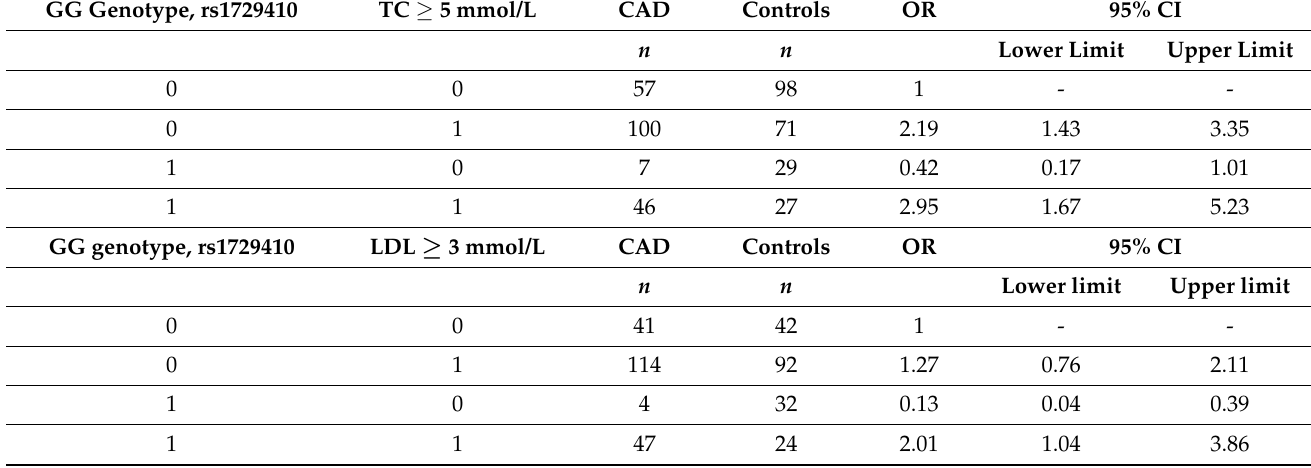
Table 6. Interaction analysis between GG homozygosity of the rs1729410 polymorphism and risk of over-normative lipid